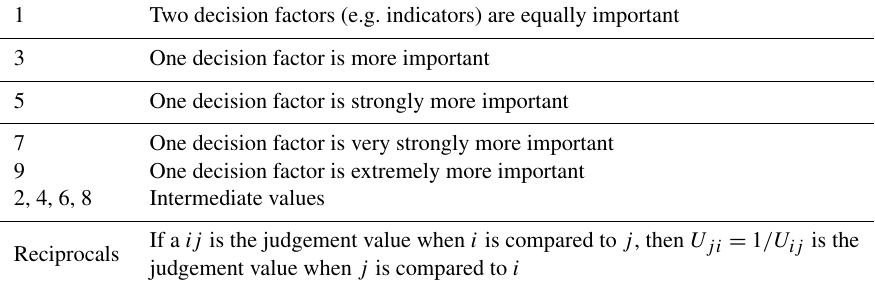
Table 2. Definition of comparative importance. 1 Two decision factors (e.g. indicators) are equally